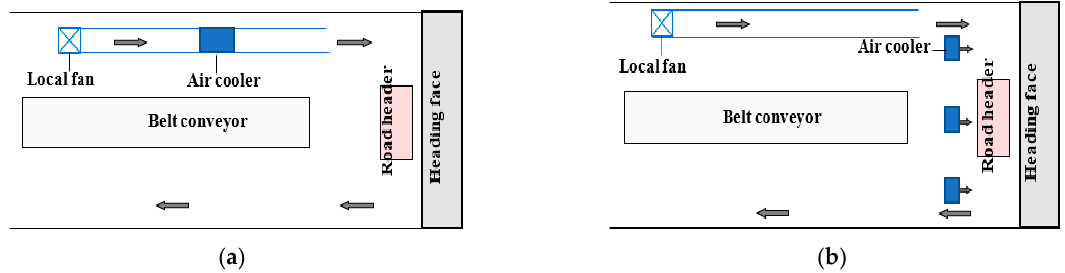
Figure 1. Layout mode of the air cooler for cooling the heading face at various locations: ( a ) Roadway; ( b ) Heading face. ( b ) Heading